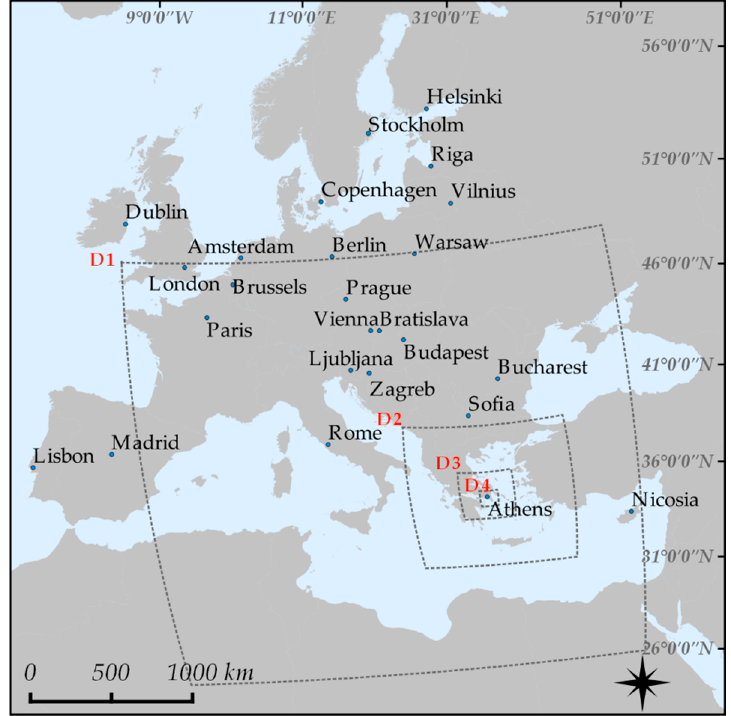
Figure 1. Location of the 25 European cities used in this study. Dashed lines indicate the Weather Research and Forecasting (WRF) simulation domains; ascending order from the lower (D1) to the higher resolution domain (D4).